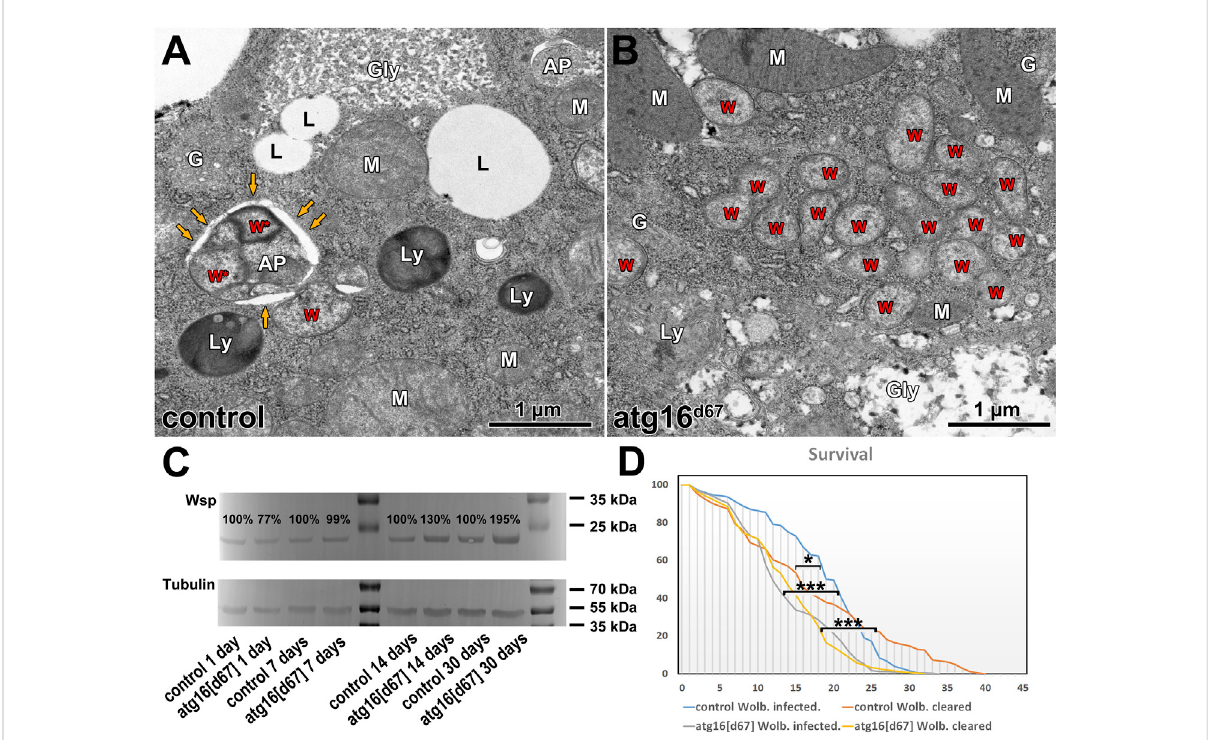
FIGURE 3 Wolbachia in aging animals. Ultrastructure of fat cells of 30 days old adults reveal Wolbachia inside autophagosomes (A) , and large Wolbachia clusters in atg16 mutants (B) in the absence of autophagosomes. W: Wolbachia, AP: autophagosome, yellow arrows point to the outer limiting membraneofan APwith Wolbachiainside(W*).Ly:lysosome,G: Golgiapparatus, Gly:glycogen granule, L:lipid droplet, M:mitochondrion.Western blotfromadultlysates (C) revealthattheamountofdetectableWspgraduallyincreasesinatg16mutantscomparedtocontrols.Lifespancurves of Wolbachia infected versus cleared controls and atg16 mutants (D) show that atg16 mutants live shorter than controls (***: p < 0.001) and their lifespan is unaffected by infection status (p: NS). Wolbachia infection initially increases the survival of control fl ies, (*: p = 0.042) but this effect declines over